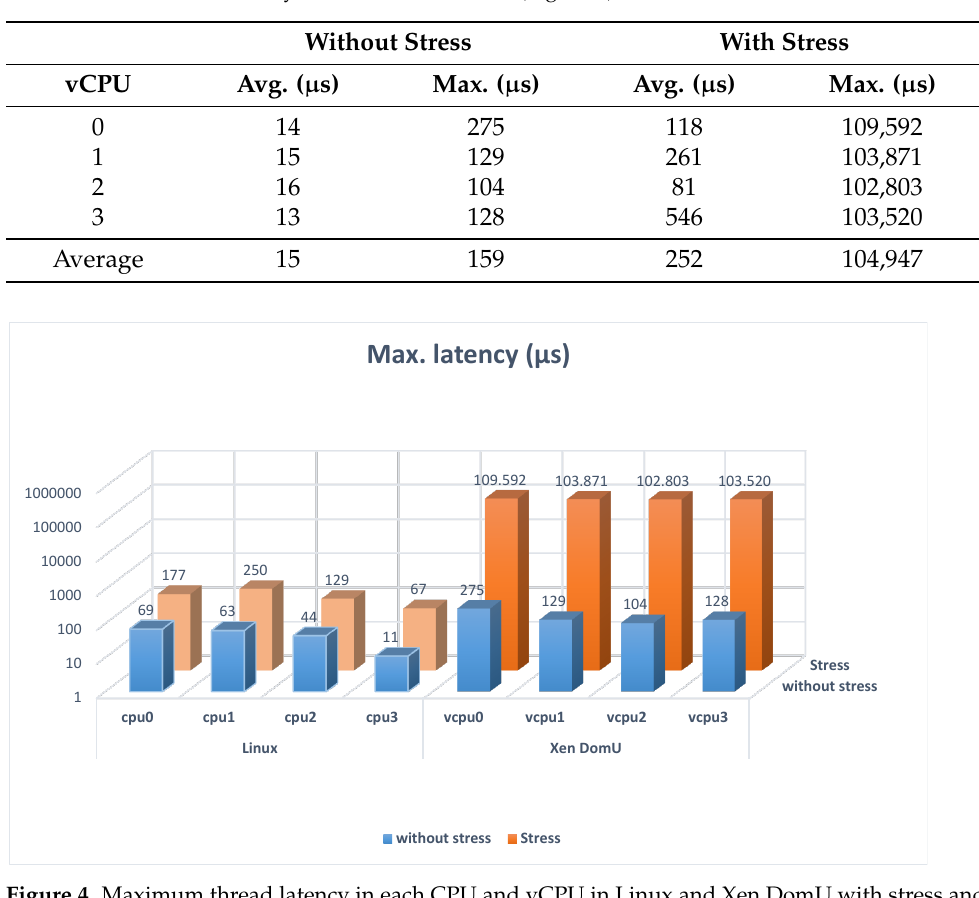
Table 2. Linux thread latency on Xen DomU: Linux (Figure 2).